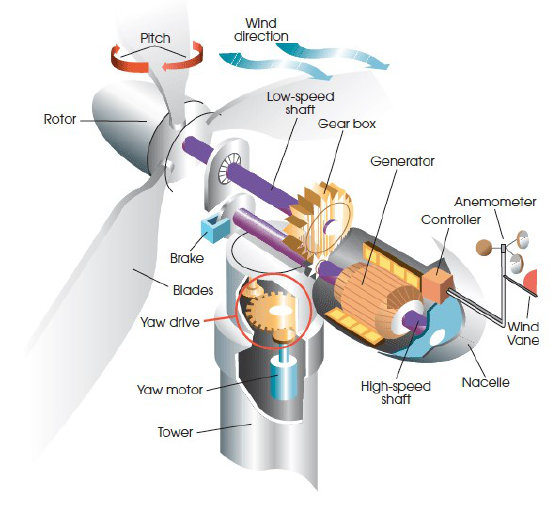
Figure 1. A Horizontal Axis Wind Turbine - components [4]